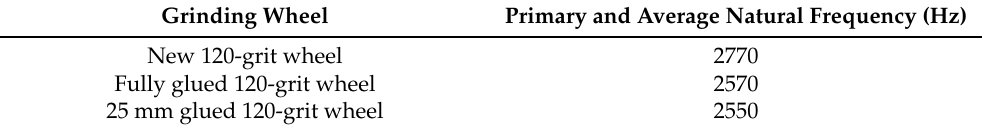
Table 6. Average and primary natural frequency of 120-grit medium-grade wheels after 60 impact hammer